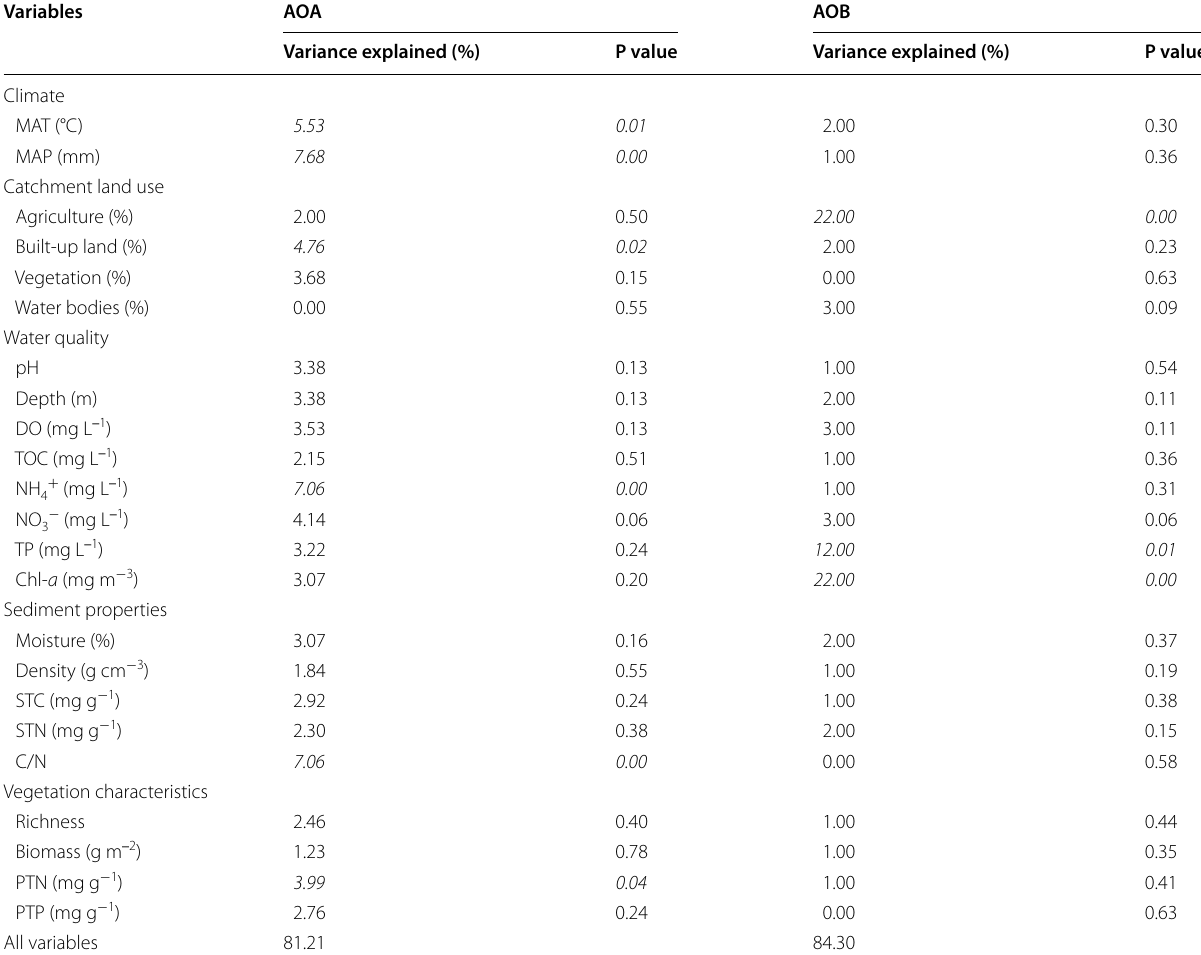
Table 4 Contributions of different factors to the variation in the community structure of AOA and AOB as revealed by canonical correspondence analysis or redundancy